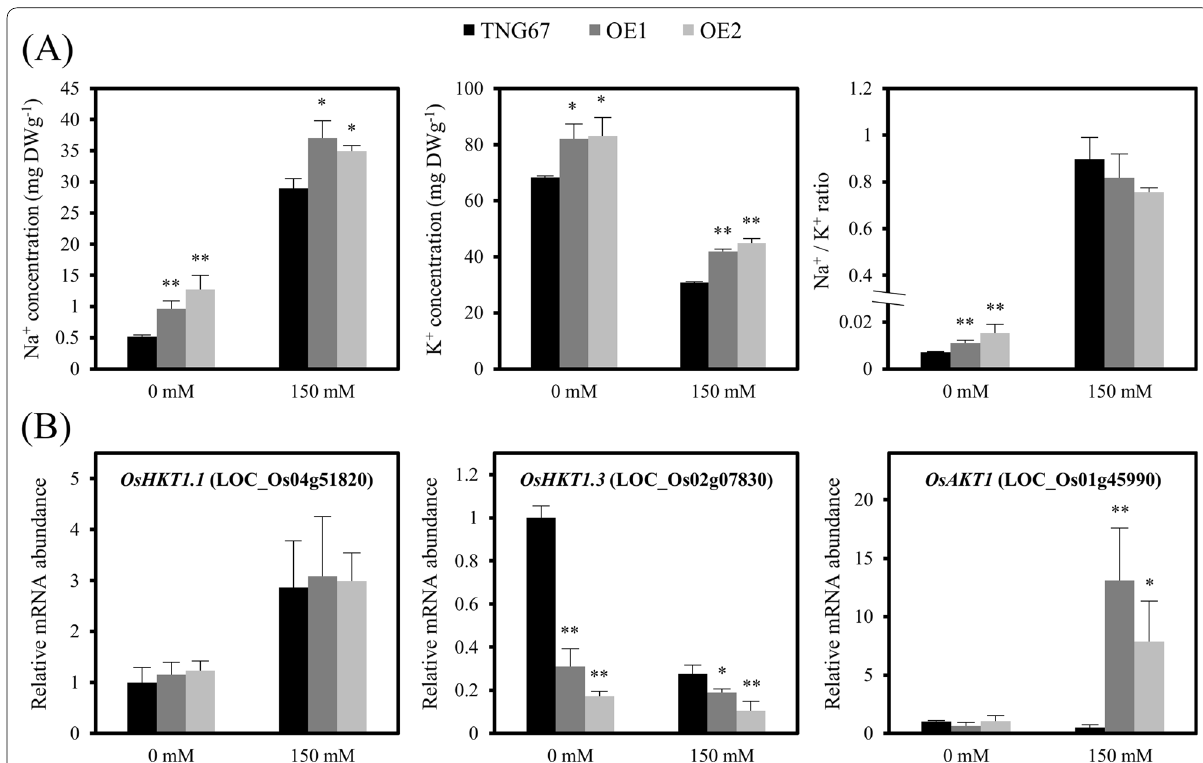
Fig. 5 Overexpression of OsERF106MZ impairs the homeostasis of sodium and potassium in transgenic shoots. a Na + and K + contents and Na + / K + ratio in the shoots of Tainung 67 and OsERF106MZ ‑overexpressing rice plants. b Quantification of OsHKT1.1 , OsHKT1.3 , and OsAKT1 mRNAs in the shoots of Tainung 67‑ and OsERF106MZ ‑overexpressing rice plants. The values are the mean SE of at least four biological replicates, each with two ± technical replicates. Asterisks indicate significant differences (* P < 0.05 and ** P < 0.01) in comparison to the corresponding WT (Tainung 67) based on Student’s t ‑test. The seedlings were grown on basal medium for 7 days and then transferred to basal medium containing 0 or 150 mM NaCl